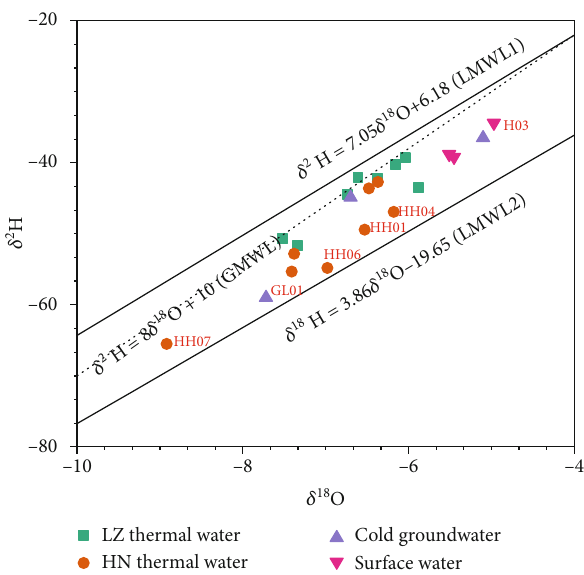
Figure 7: δ 2 H- δ 18 O plot for all hot spring samples with the GMWL and LMWL at LZ and HN. Table 2: Calculated reservoir temperature ( ° C), deuterium excess parameter ( ‰ ), recharge altitude (m), and reservoir depth (km) for thermal